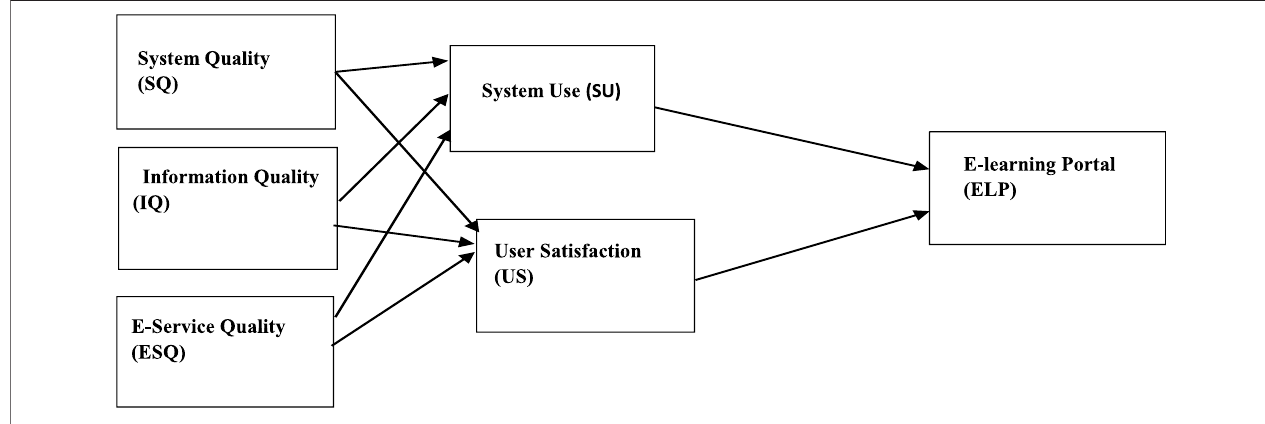
FIGURE 2 | The research framework of this study.